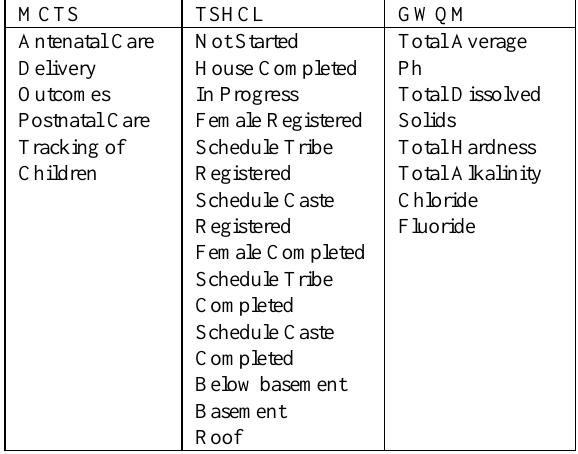
Table 1 : Attributes for which thematic maps are created MCTS TSHCL